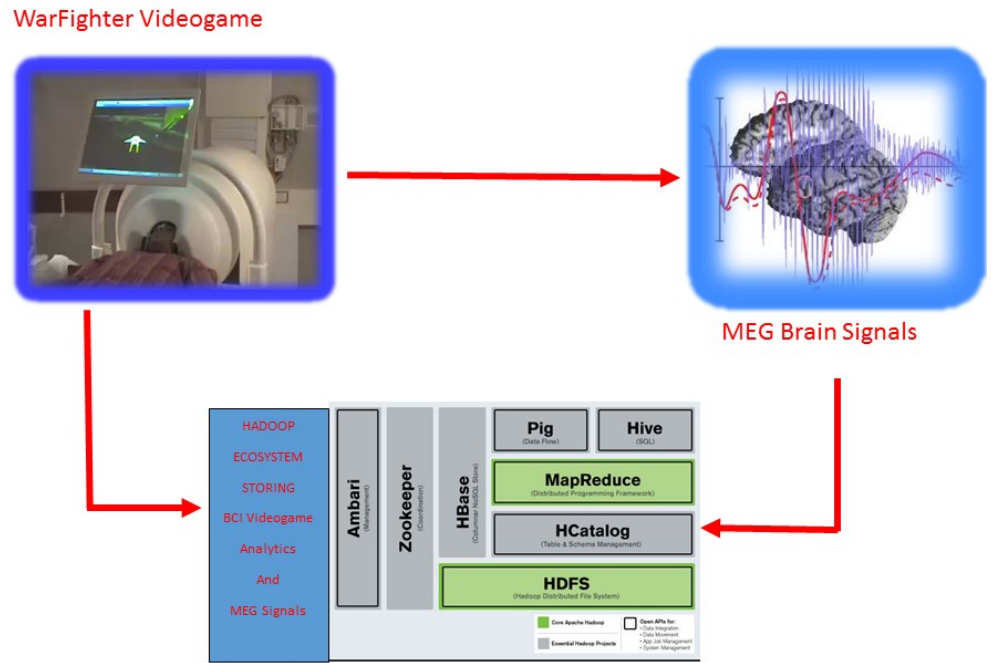
Figure 2. MEG BCI utilizing the Hadoop